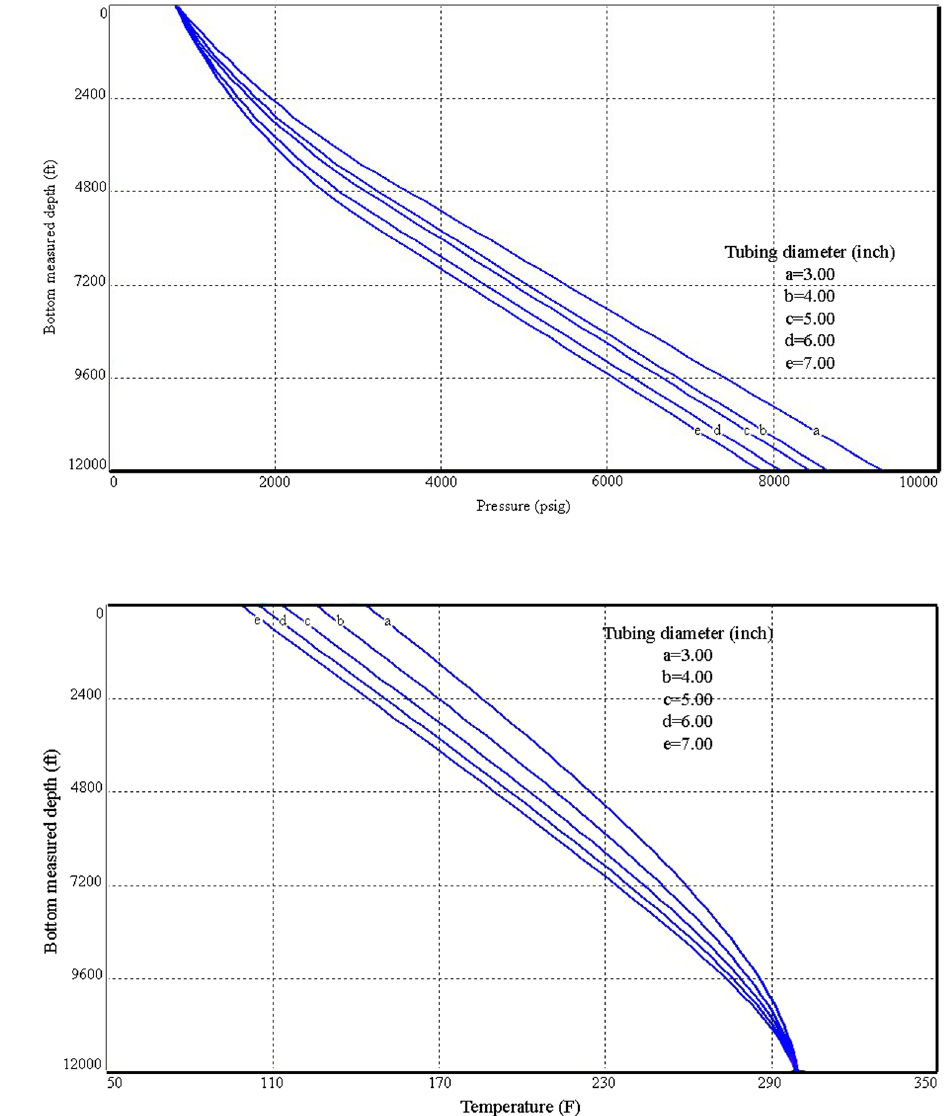
Fig. 17 Pressure profile in the well for different tubing sizes